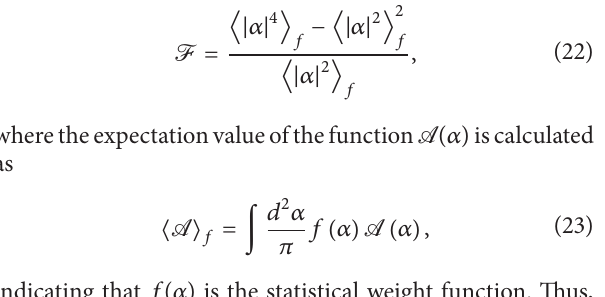
Figure 3: Complexities 𝐶 𝑃 , 𝐶 𝑄 , and 𝐶 𝑊 versus the temperature 𝑇 in (ℏ𝜔/𝑘 𝐵 ) -units. The solid line is the case 𝑃 , the dashed one is the Wigner one, and the dotted curve is assigned to the Husimi